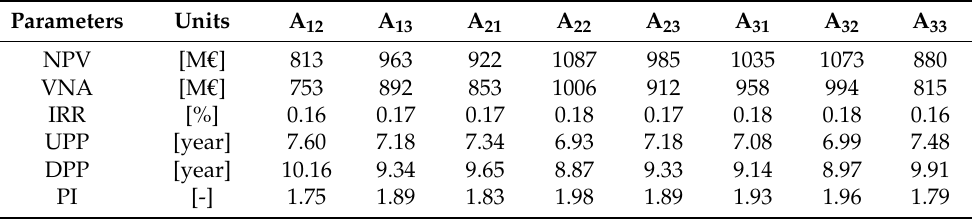
Table 11. The economical assessment of the CFPP system with a single-stage of membrane technology (no vacuum pump